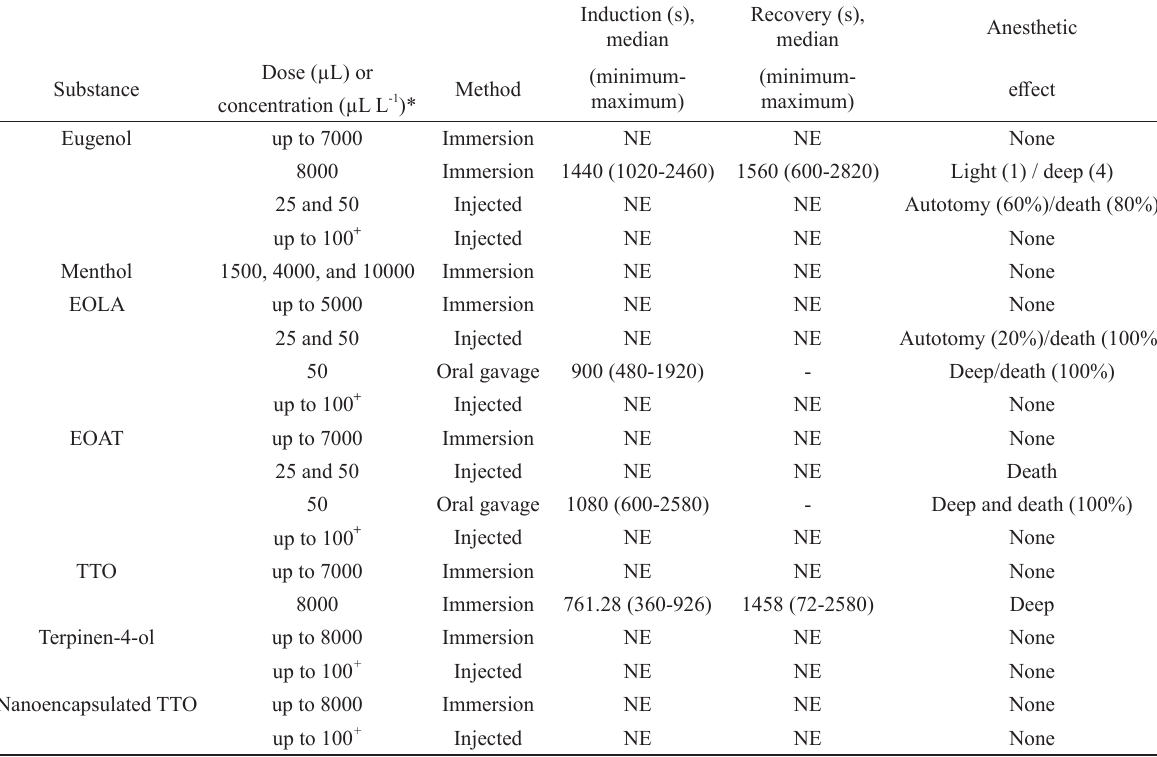
Method of exposure, induction and recovery times (in seconds), and anesthetic effects of essential oils and compounds tested in Neohelice